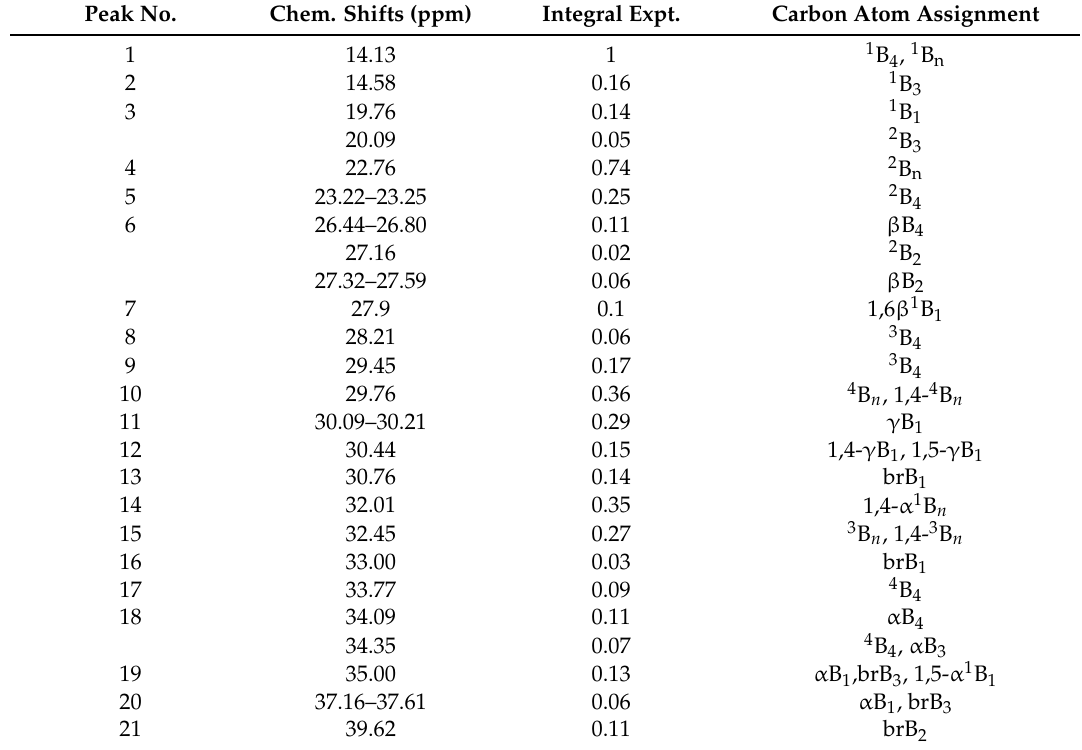
Table 2. Chemical shifts and assignments for the numbered peaks in Figure 1. Peak No. Chem. Shifts (ppm) Integral Expt. Carbon Atom